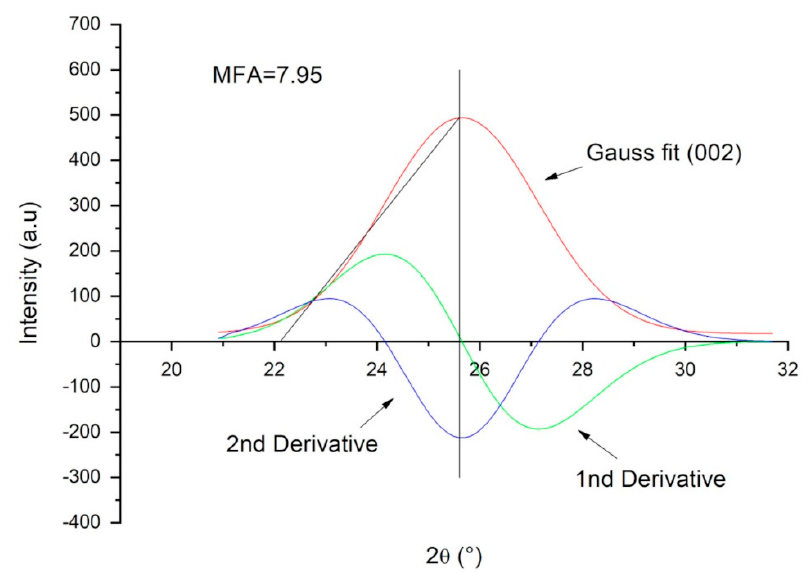
Figure 6. TVF microfibrillar angle.